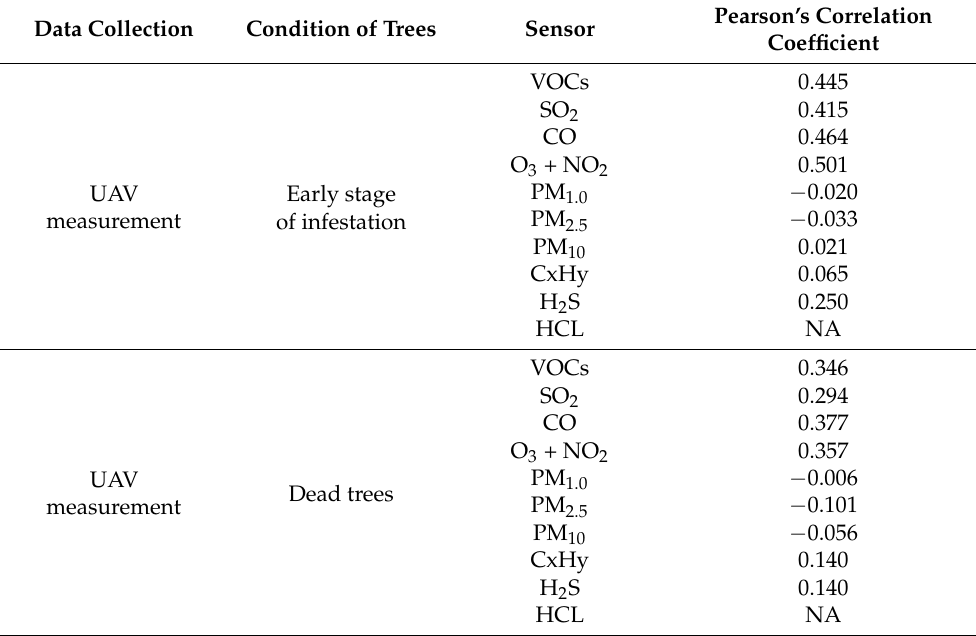
Table 4. Pearson’s correlation coefficient results of UAV collection for early-stage infestation and dead